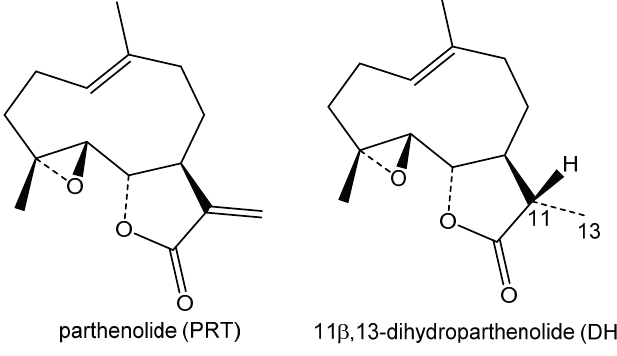
Figure 1. Structures of parthenolide (PRT) and 11 β ,13-dihydroparthenolide